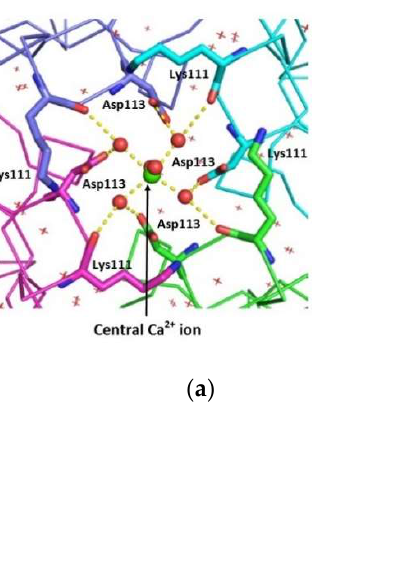
( e ) Figure 8. Conserved structural features of NA produced by HEK293-6E cells. ( a ) Coordination of the central Ca 2+ ion. ( b ) Coordination of Ca 2+ ion 1. ( c ) Coordination of Ca 2+ ion 2. ( d ) Open 150-cavity observed for HEK NA. 150-cavities of other NAs can be found in supplemental Figure 4. ( e ) Position of 150s-loop. The HEK NA structure (chain A) is represented by a transparent grey surface and dark grey cartoon secondary structure. The 150s loop of published NA structures have been superposed onto the HEK NA structure. Cyan 3BEQ. Light pink 3SAL. Grey 1F8E. Purple 4K1K. Orange 3TI4. Dark Green 2HTY. Teal 3NSS. Hot pink 4KS1. Each monomer is stabilised by seven or eight disulfide linkages which connect the following residues: Cys92-Cys417, Cys124-Cys129, Cys183-Cys230, Cys232-Cys237, Cys278-Cys291, Cys280-289, Cys421-447, Cys318-336 (Figure 7). The formation of these disulfide bonds in their native combinations suggests HEK cells have a suitable folding environment for NA. The disulfide bond between Cys318-Cys336 was broken in all chains, except chain E, possibly due to radiation damage in the X-ray beam. We also ob- served density for two conformations of other cysteine residues involved in disulfide bonds, so these were modelled in both the disulfide and free cysteine, with partial occu- pancies refined. The neuraminidase active site, which is comprised of Arg118, Asp151, Arg152, Arg224, Glu276, Arg292, Arg371 and Tyr406, is present in its expected confor- mation (Figure 7).